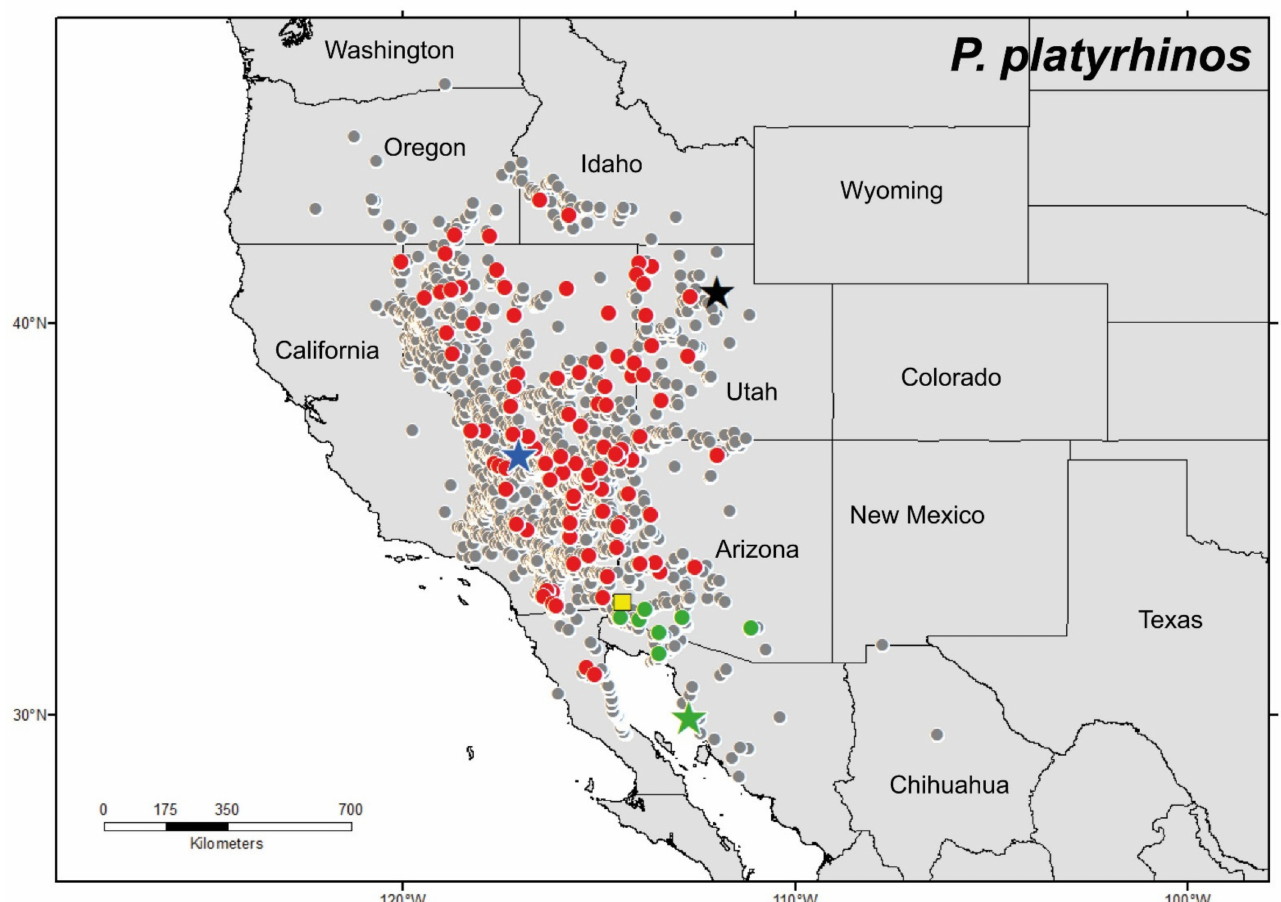
Figure 16. Map showing distributional records of Phrynosoma platyrhinos . Red circles = genetically confirmed records of P. p. platyrhinos ; green circles = genetically confirmed records of P. p. goodei ; yellow square = genetically confirmed records of P. cf. platyrhinos (Yuma Proving Grounds, California); gray circles = records that have not been genetically confirmed; black star = type locality of P. platyrhinos ; blue star = type locality of Anota calidiarum ; green star = restricted type locality of P. p. goodei